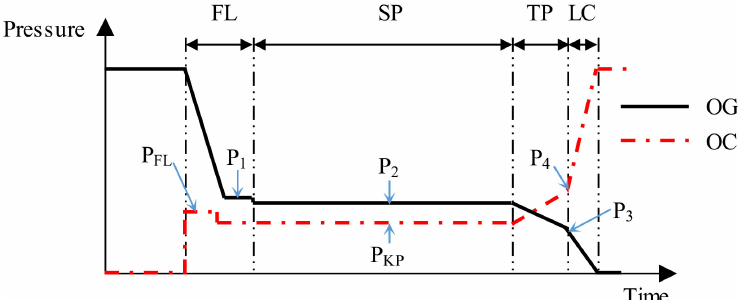
Figure 6. Change in the clutch control pressure at different shifting stages.